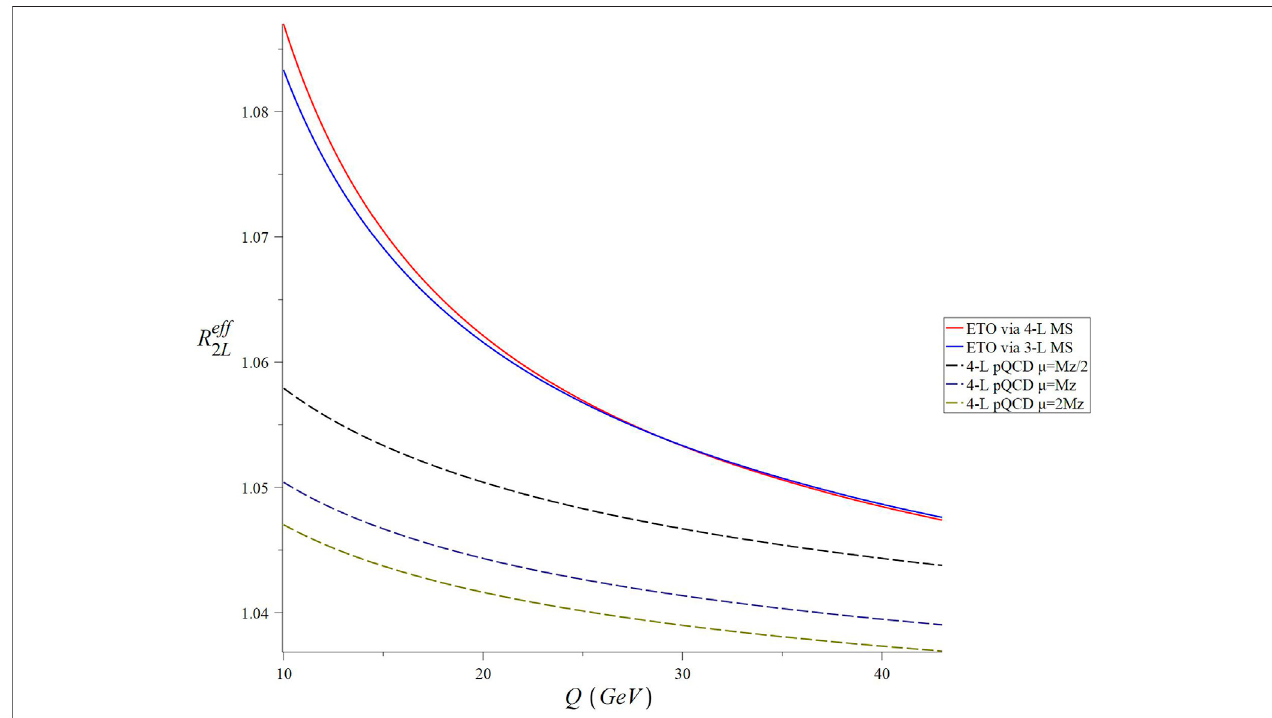
FIGURE 2 | Q dependence of RSS-independent R eff at two loops matched with three- and four-loop MS and compared to four-loop perturbative QCD in the MS scheme for